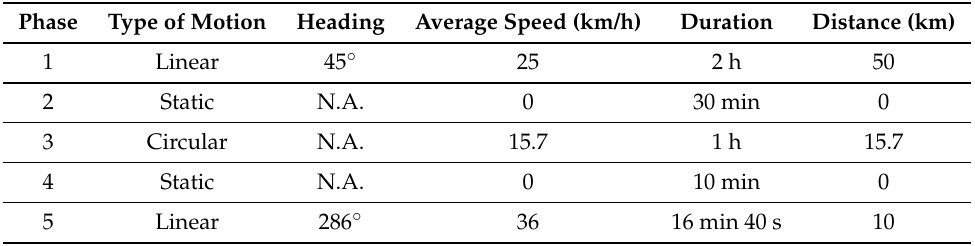
Table 2. Parameters of the simulated path of the ship, decomposed by different kinematics and trajectories.